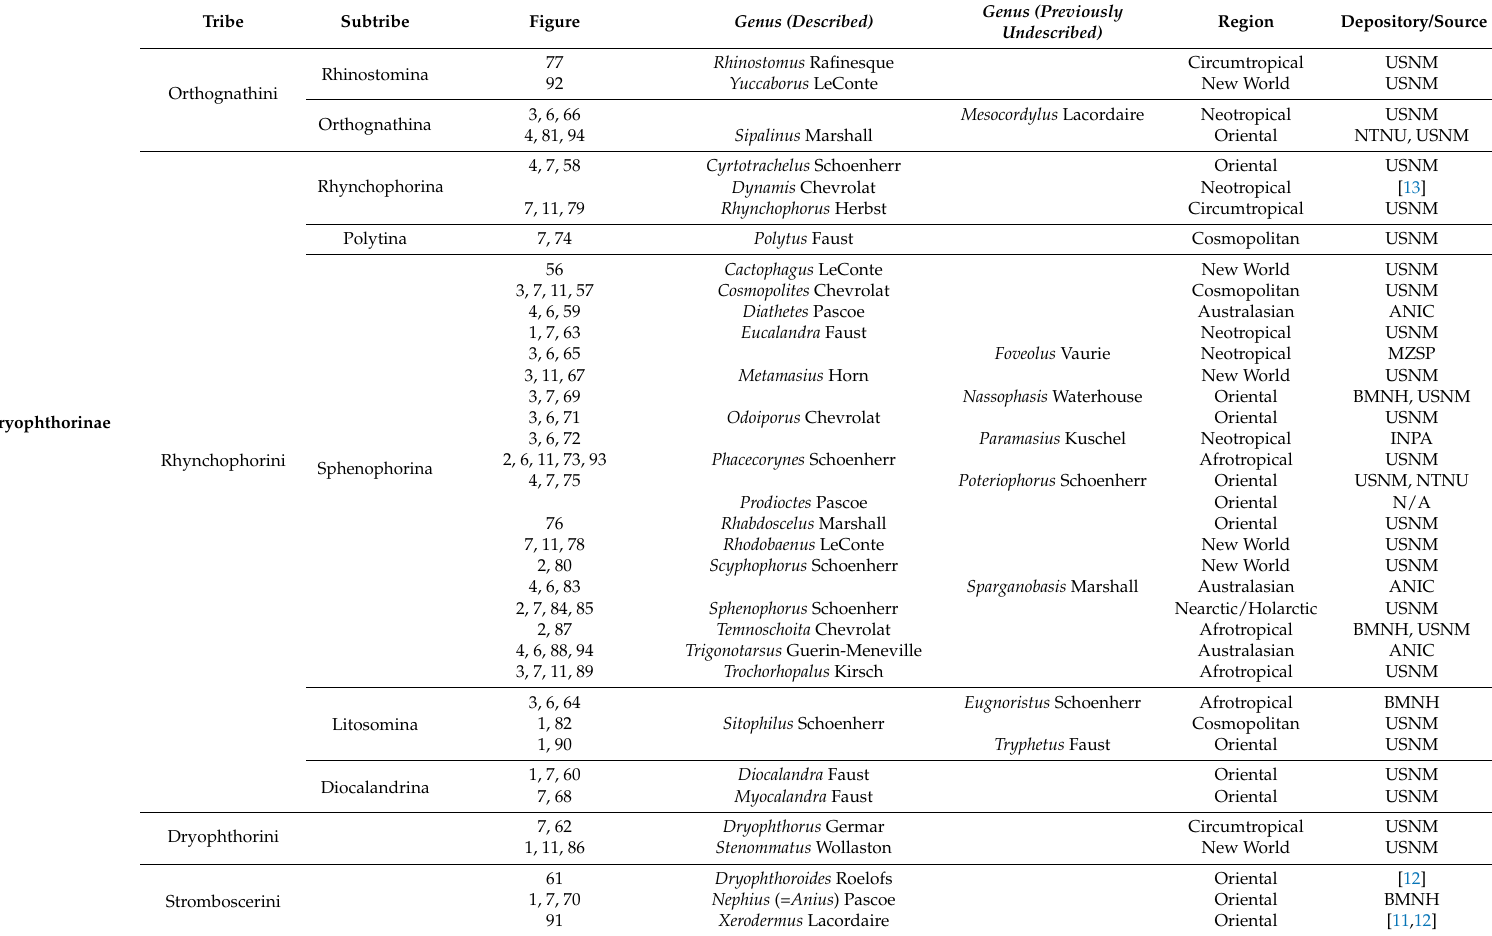
Table 1. Genera of known dryophthorinae larvae arranged based on current classification, biogeographic range, and depository (Australian National Insect Collection, ANIC; British Museum of Natural History, BMNH; Instituto Nacional de Pesquisas de Amazonias, INPA; Museu Zoologico de Sao Paulo, MZSP; National Taiwan Normal University, Taipei, NTNU; United States National Museum, USNM). Paramasius Kuschel is here included as a separate genus from Metamasius Horn; however, this was done in an attempt to uncover potential characters that may distinguish this once valid genus from Metamasius . This table references the figure plates of each